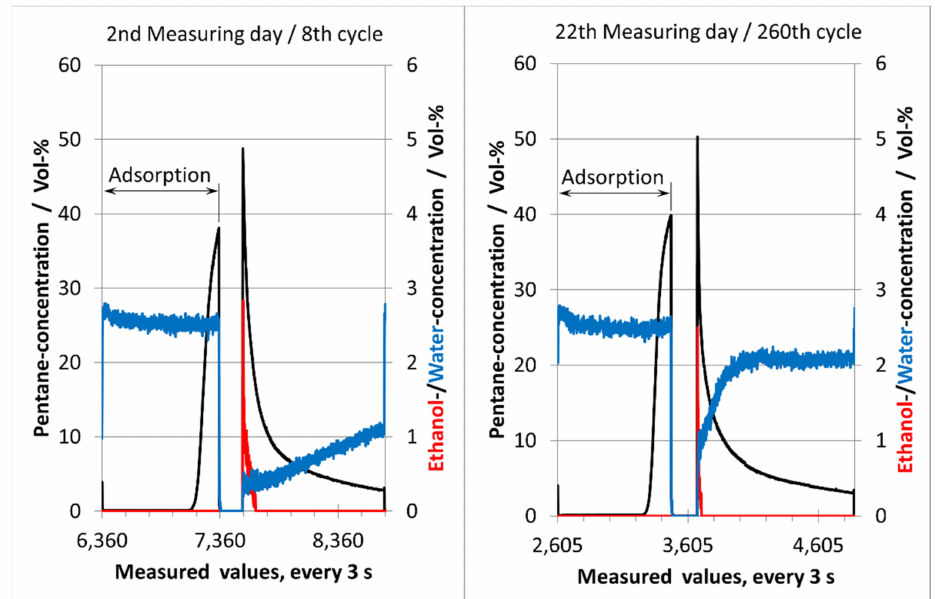
Figure 13. No breakthrough of ethanol for the system E10/humid N 2 in the 8th and 260th